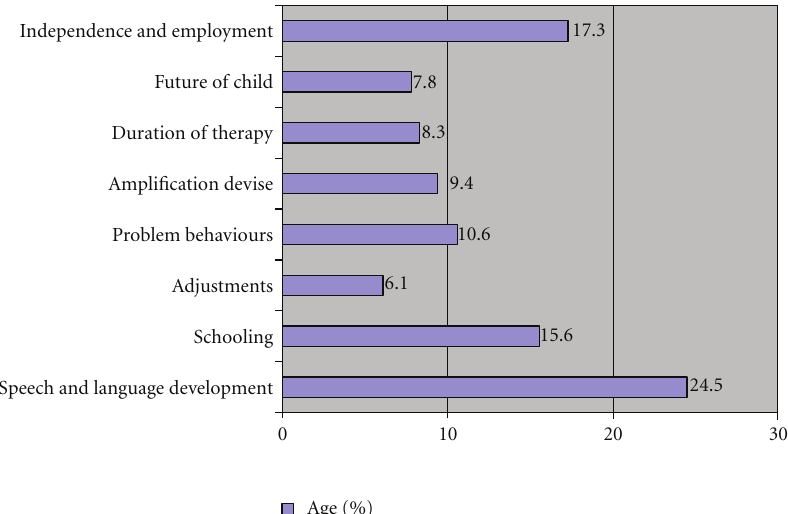
Figure 2: Queries of group II mothers regarding their